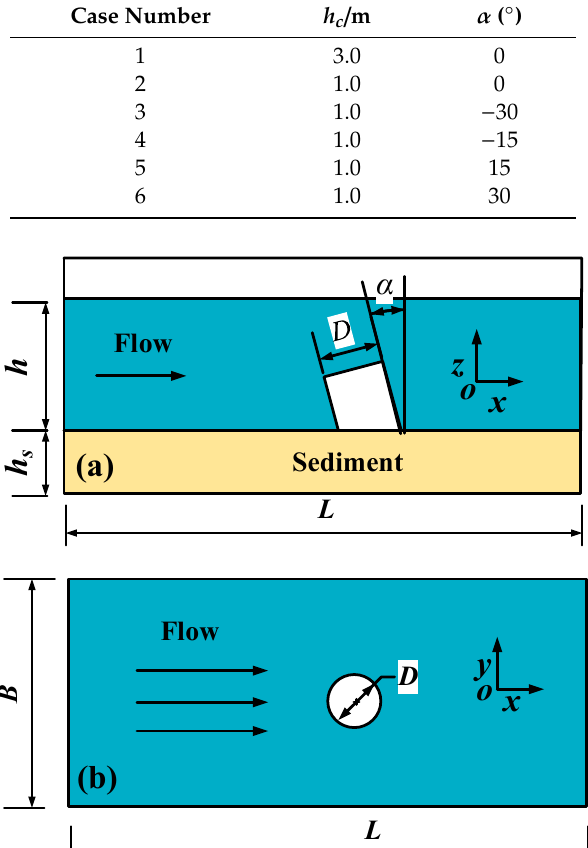
Figure 4. Time evolution of maximum scour depth around the cylinder.